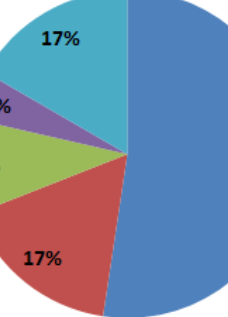
Figure 2. Tinnitus in firefighters. The tinnitus functional index (TFI) score of 22 firefighters was 0 (no tinnitus) and for 7 firefighters it was in the 0–9 range, suggesting that tinnitus was not a problem. The TFI score of 4 firefighters was in the 10–20 range and for 2 firefighters it was in the 21–29 range, suggesting that tinnitus was a mild-to-moderate problem. However, the TFI score of 7 firefighters was above 30 suggesting that tinnitus was a severe problem.